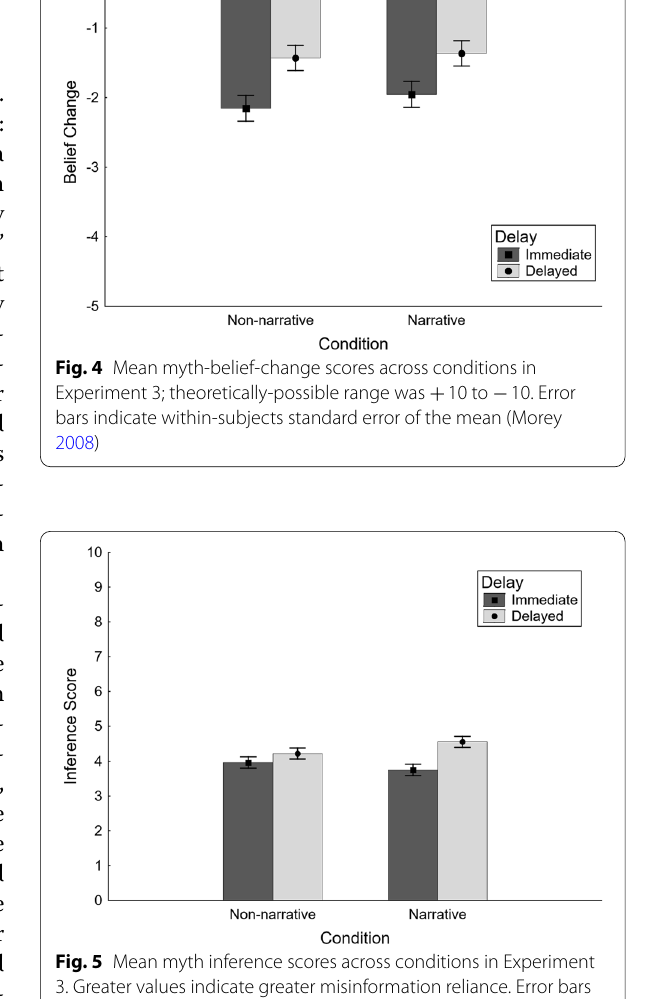
Fig. 5 Mean myth inference scores across conditions in Experiment 3. Greater values indicate greater misinformation reliance. Error bars indicate within-subjects standard error of the mean (Morey